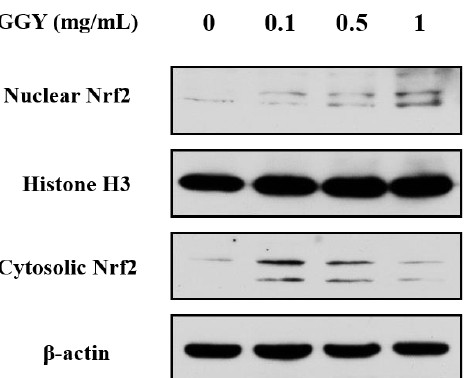
Figure 5. SGGY activated the Nrf2 of SH-SY5Y cells. Cells were pre-incubated for 12 h with indicated concentrations of SGGY (0.1, 0.5, and 1 mg/mL). The nuclear translocation of Nrf2 was detected by Western blotting.